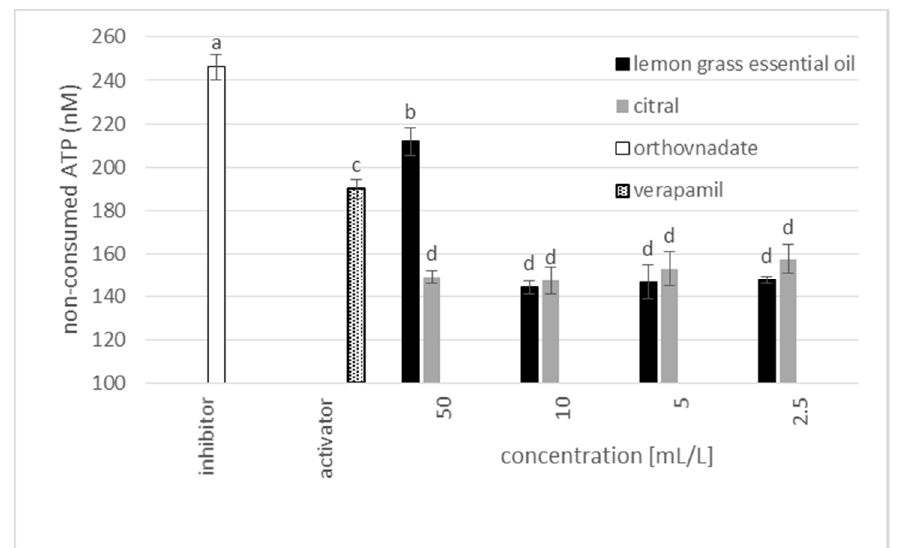
Figure 5. P-glycoprotein activity modulation. Orthovanadate was used as a known inhibitor of P-gp, Verapamil was used as a known activator of P-gp.